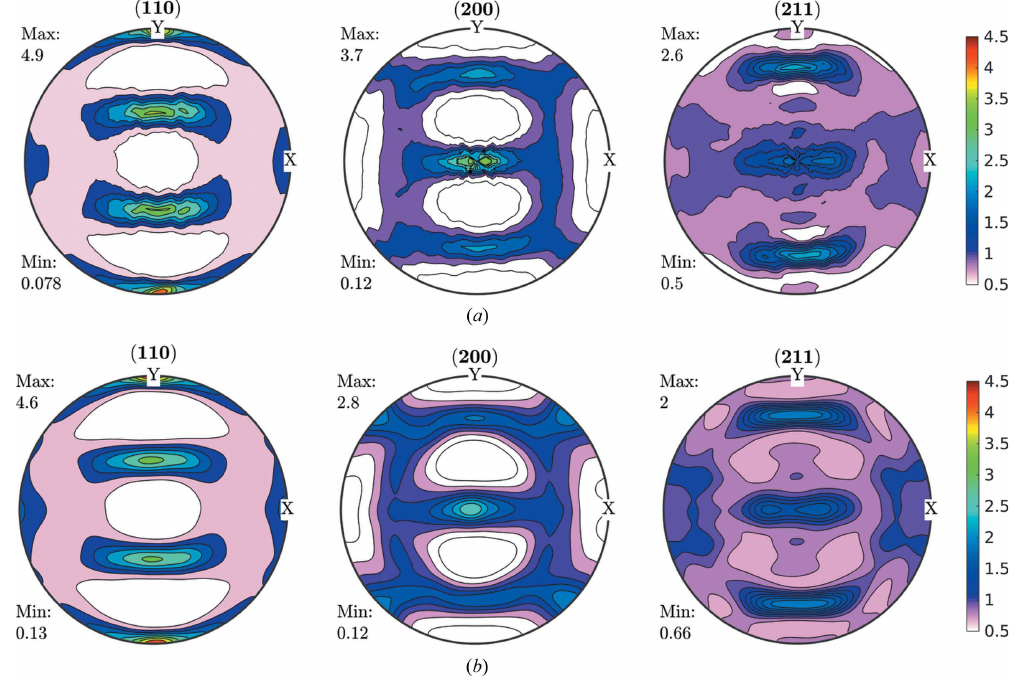
Figure 2 Intensity PFs for the cold-rolled sample by post-processing image plates. ( a ) Initial data obtained as described in the text. ( b ) Recalculated from ODFas coming out from MTEX software. The textures obtained can be easily identified as typical rolling textures for